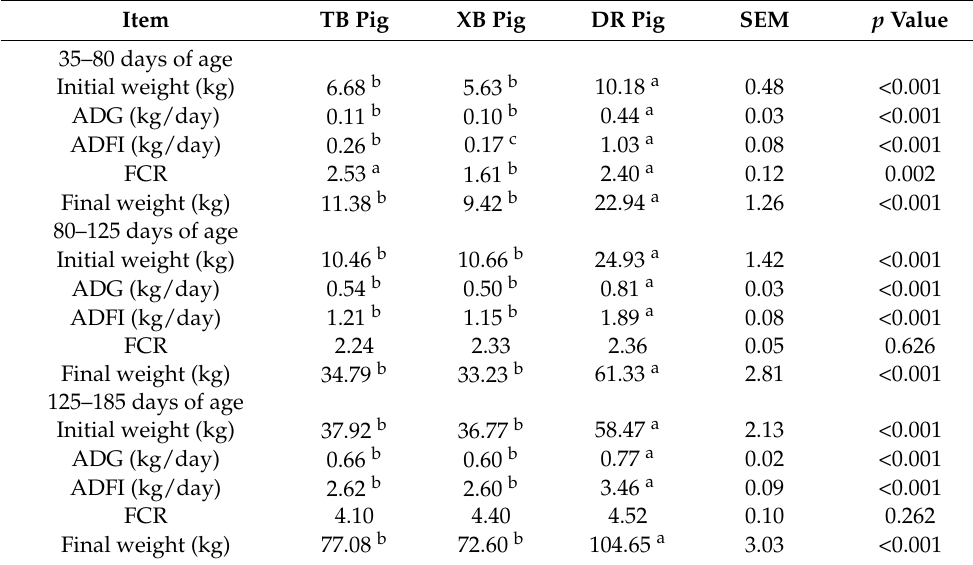
Table 3. Growth performance and feed efficiency of three pig breeds at different ages.